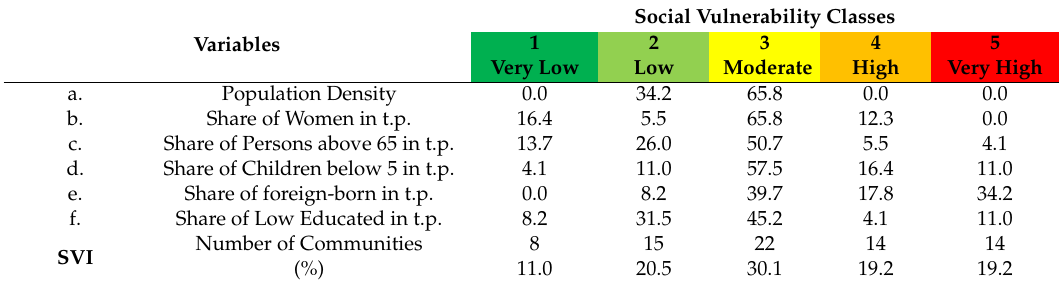
Table 3. Number of coastal communities (as percentage% of the total coastal municipal communities of the Peloponnese) in each vulnerability category (1–5) for the social variables (a–f) of the SVI.